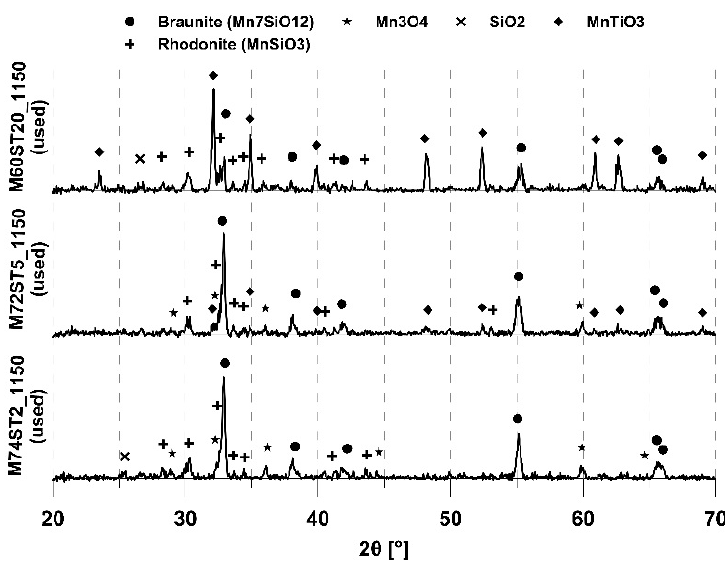
Figure 8. Diffractograms of the used samples calcined at 1150 °C.